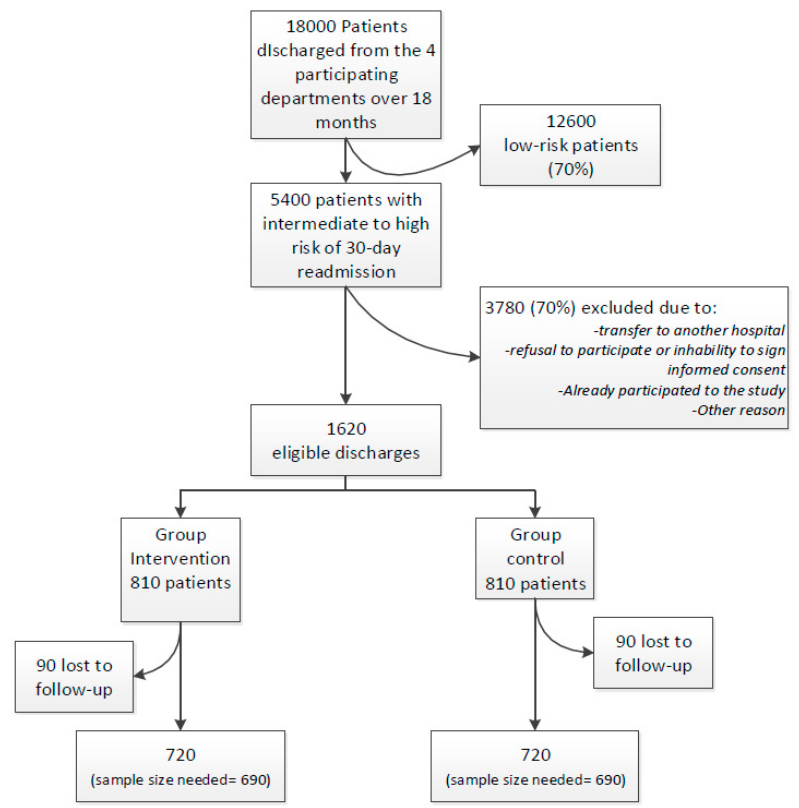
Figure 2. Projected study flow-chart with estimation of the number of included and excluded pa- tients.